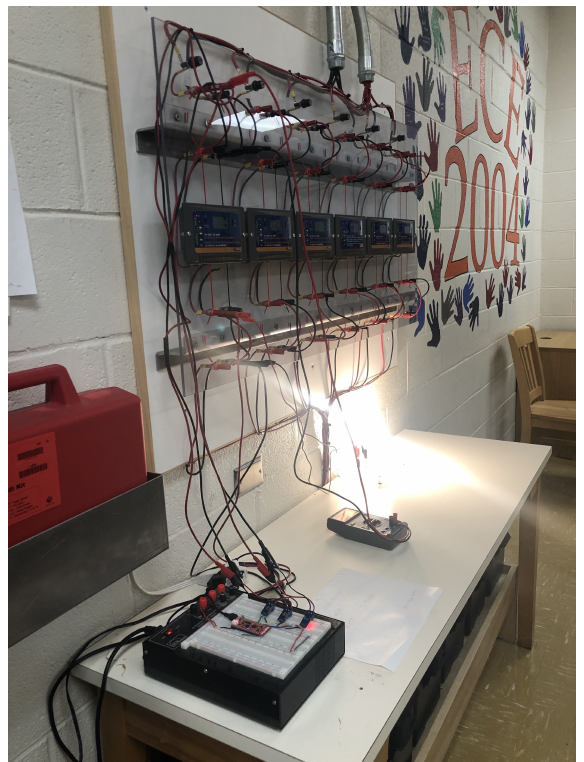
Figure 10. Experimental setup of the proposed SCADA